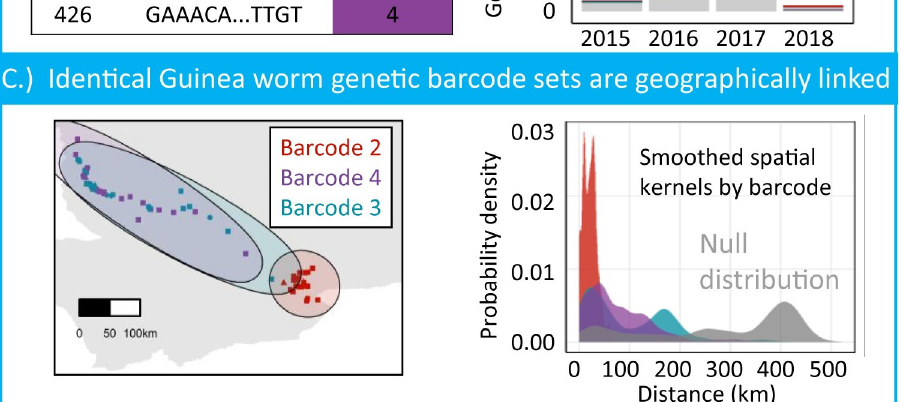
not differ by host (S1(D) Fig). The mean successful assignment was 48% and 61% respectively, compared to the mean for random chance of 49% (35% and 65% confidence interval).